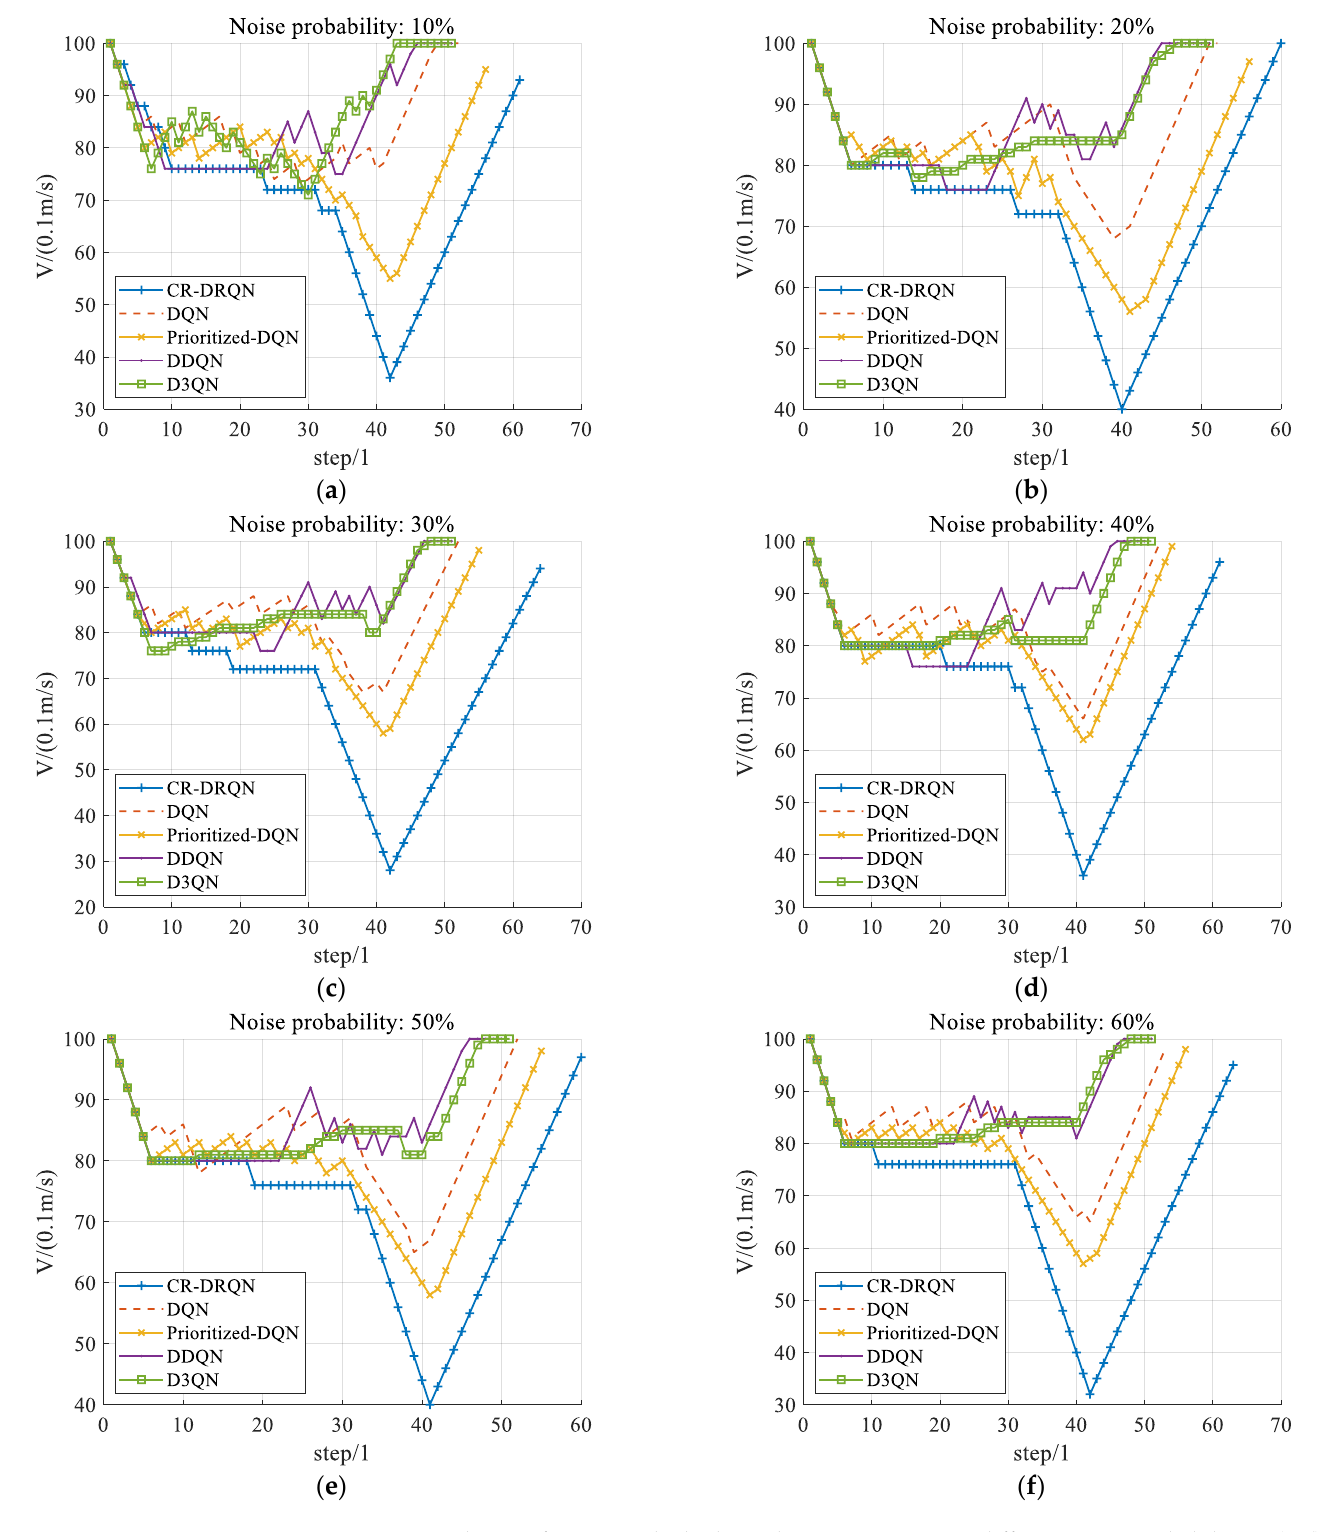
Figure 6. Velocity of an ego vehicle through an intersection at different noise probabilities. ( a – f ) present the results at the noise probabilities of 10–60% respectively.